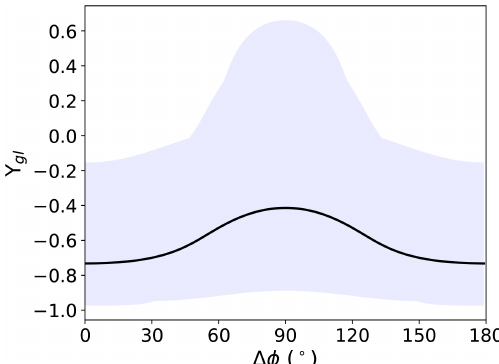
Figure 9. Correlation between the change in buttressing number and the change in ice speed across the grounding line (i.e., ϒ gl from Eq. 13) for the entire MISMIP + grounding line. The horizontal axis shows how ϒ gl varies as a function of the direction n used to define the normal stress, rotated counterclockwise from n p1 by (cid:49)φ . Values from the maps in Fig. 8a and b plot at (cid:49)φ values of 0 and 90 ◦ , respectively. Thus, the shaded blue region represents all possible maps for all possible values of buttressing direction. The thick black curve represents the mean value of ϒ gl for any given